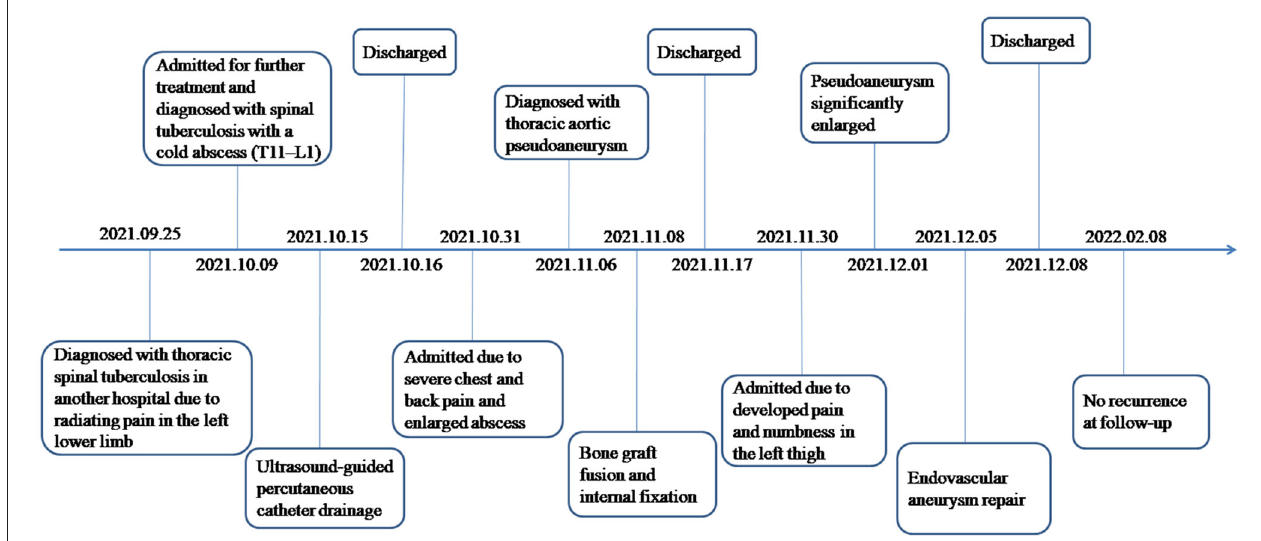
FIGURE 4 | A timeline showed the progress of the disease and the patient’s treatment and